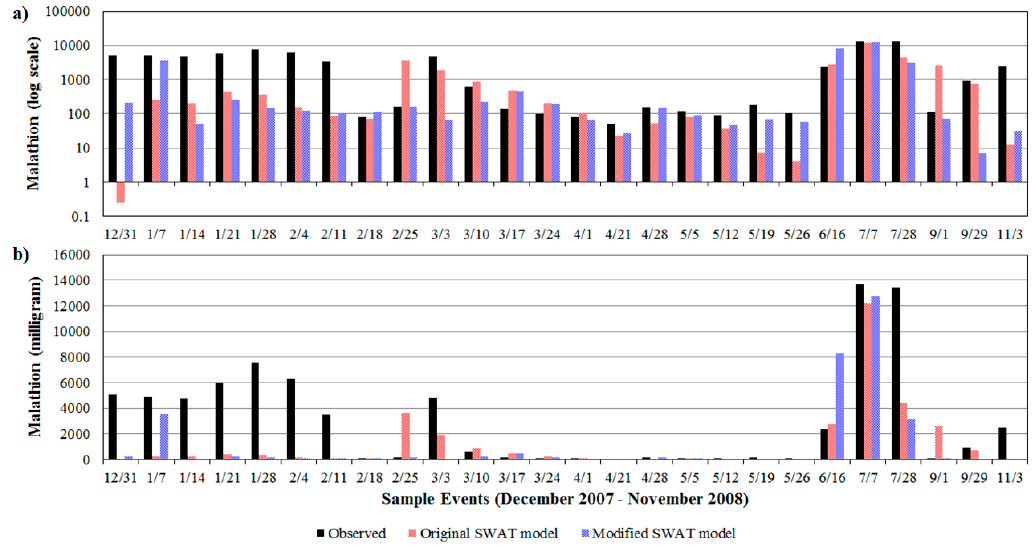
Figure 7. ( a ) Logarithmic scale (-); and ( b ) normal scale (milligram) of the observed and simulated malathion loadings at Lucban Station. This shows the comparison of the observed malathion data and simulated loading by the original SWAT and modified SWAT model.